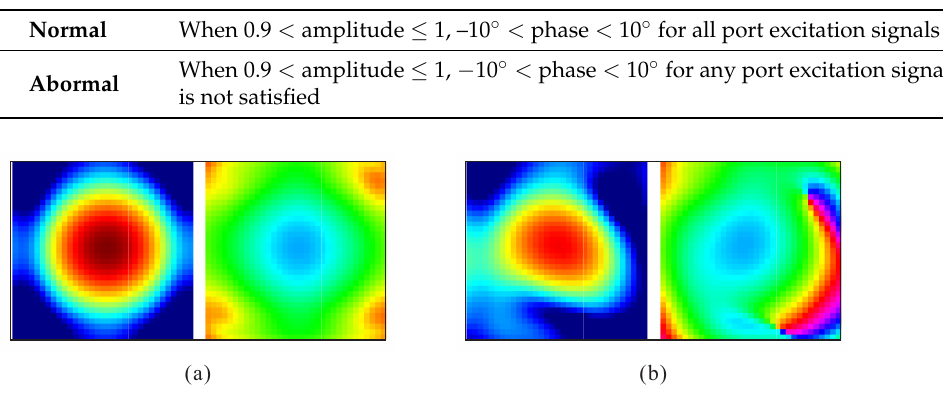
Table 2. Normal/abnormal classification criteria for array antennas.